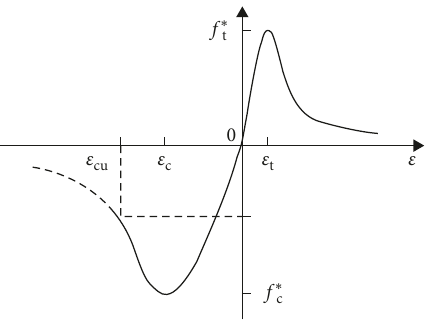
Figure 9: Stress-strain relation of